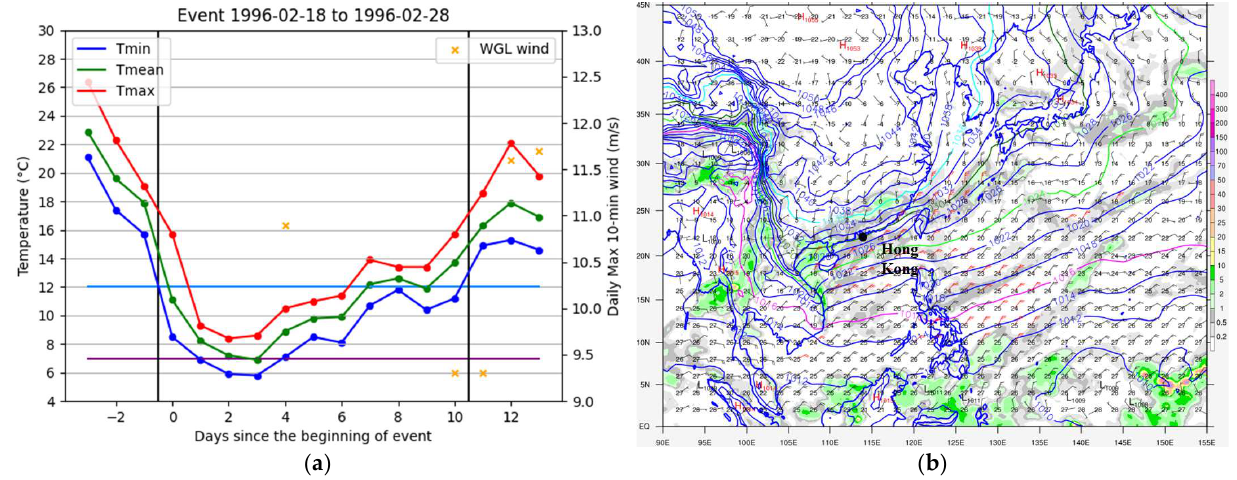
Figure 14. ( a ) Time series of the cold event on 18–28 February 1996. Plotting convention followed Figure 8. For this case, ( 𝑇 , ∆𝑇 , 𝑤 ) = (5.8 °C, −8.8 °C, undefined ). ( b ) ERA5 reanalysis field for surface winds (in wind barbs), isobars, 3-h accumulated rainfall (colored) and temperatures (in number) at 00 UTC on 20 February 1996.